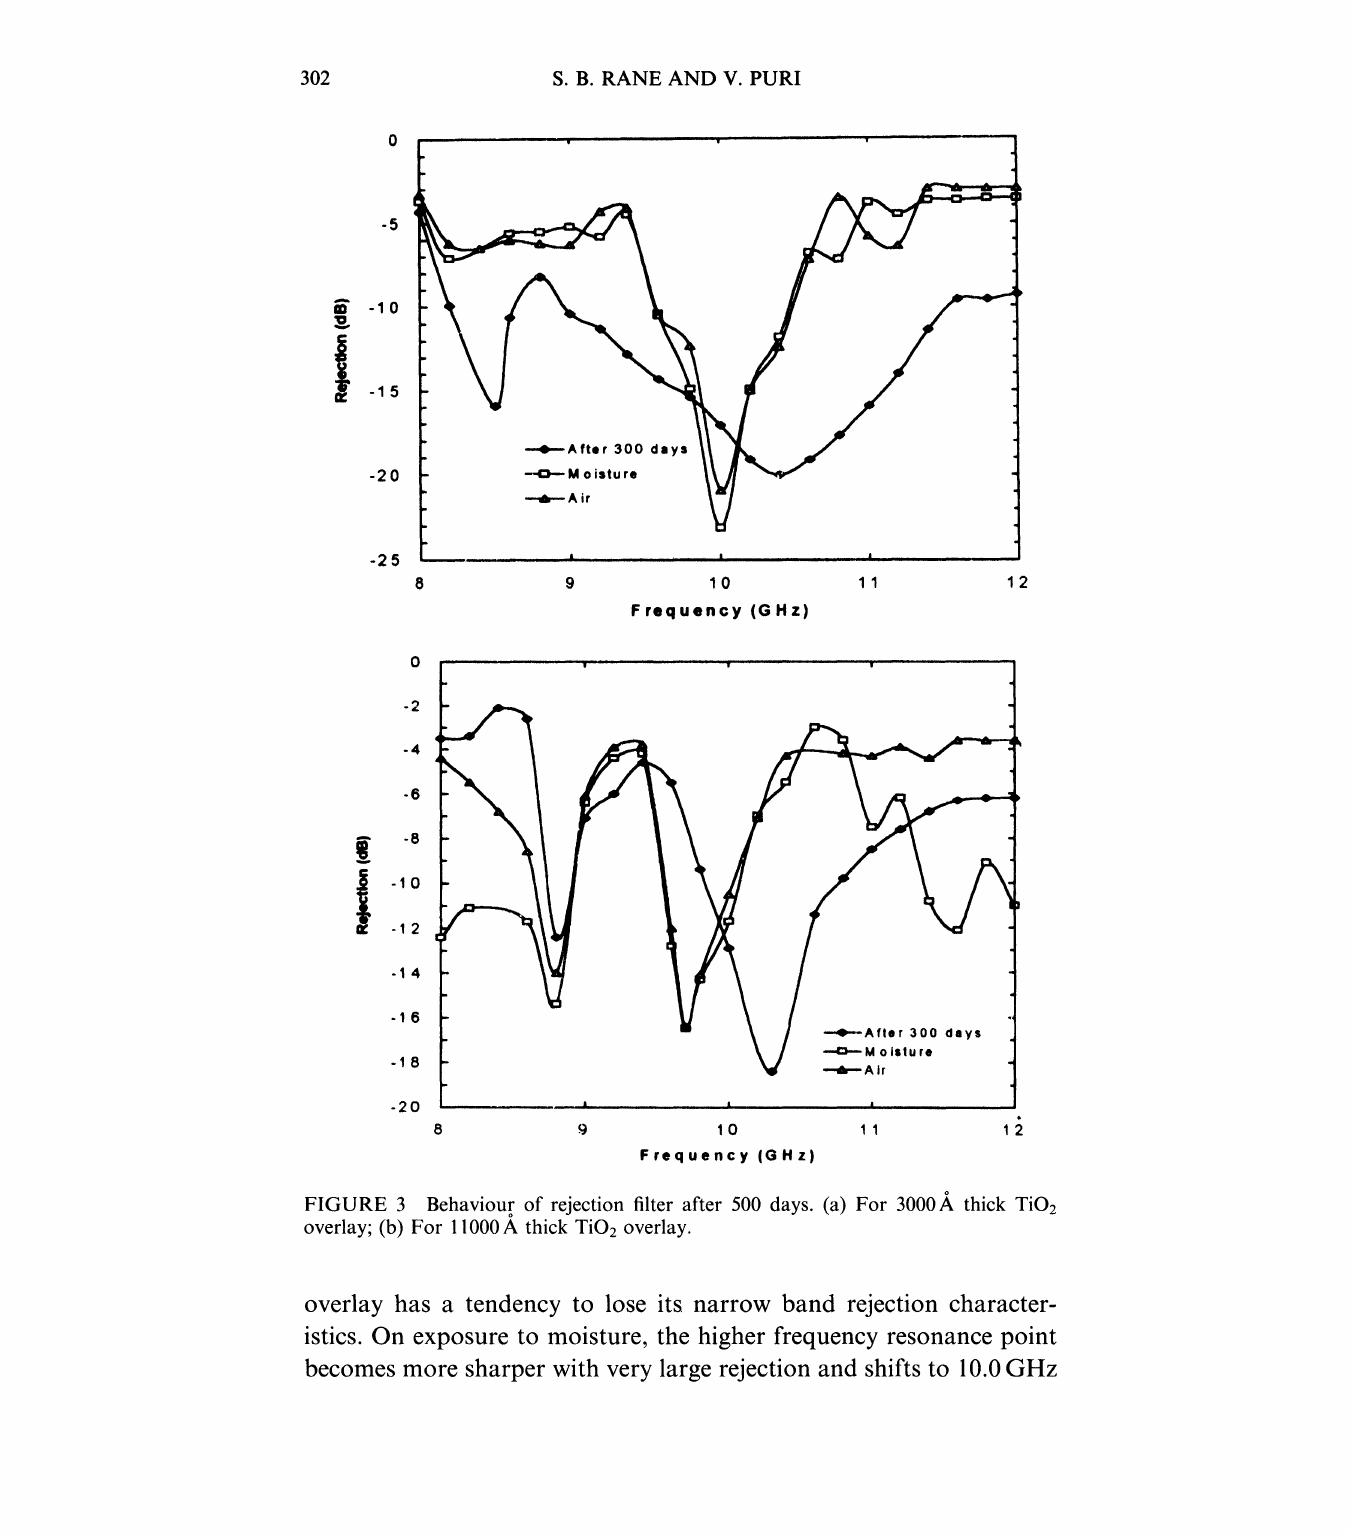
FIGURE 3 Behaviour of rejection filter after 500 days. (a) For 3000 thick TiO2 overlay; (b) For 11000 thick TiO2